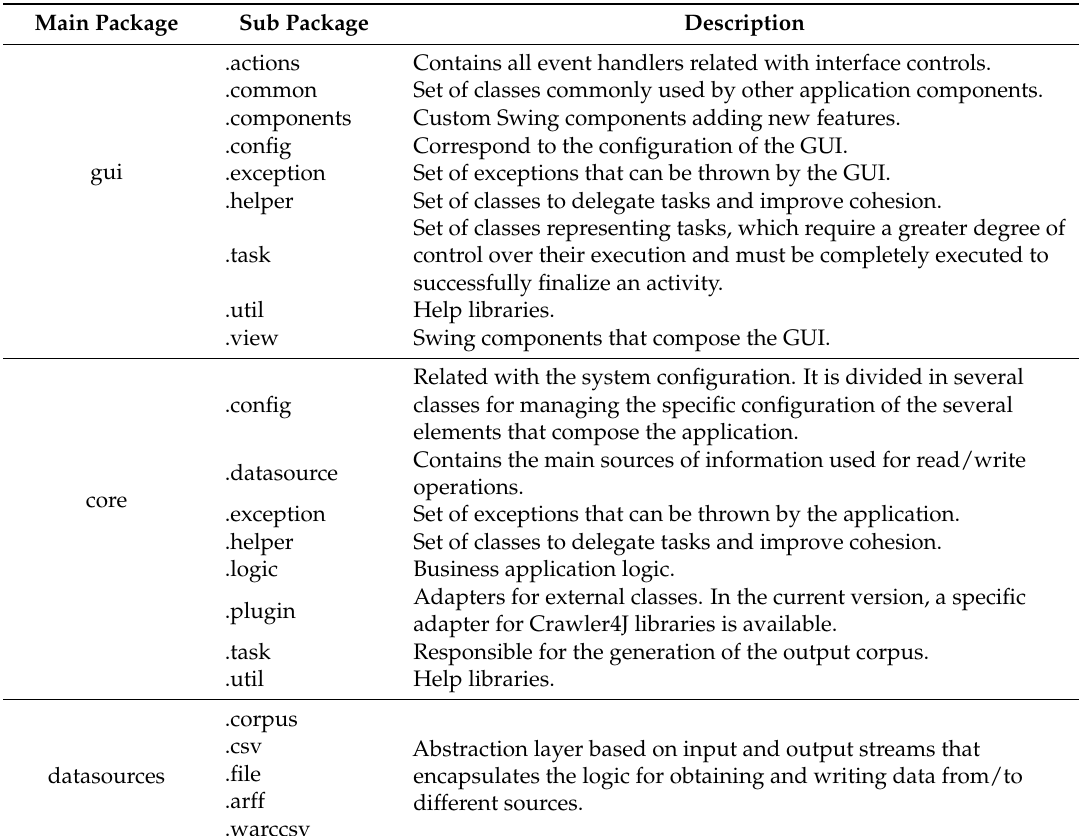
Table 3. Functionality provided by each package in